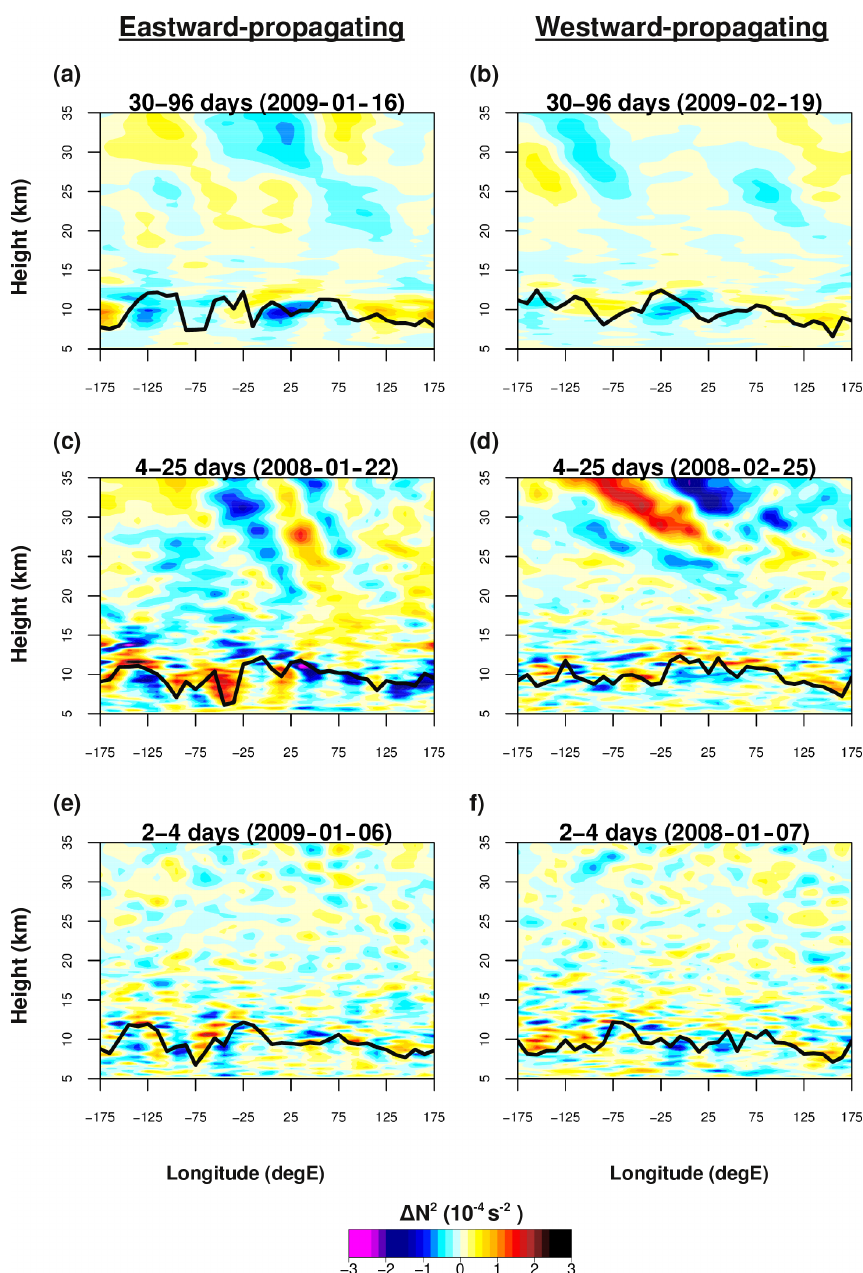
Figure 3. Longitude–height snapshots of the N 2 anomalies of the different wave spectral regions at certain dates, for the 50 ◦ N latitude band. The wave spectral regions correspond to the wavenumber–frequency domains defined in Fig. 1, except for wavenumber zero. The left column shows eastward-propagating waves, while the right column shows westward-propagating waves, and their periods are specified along with the date. The black line denotes the thermal tropopause from GPS-RO